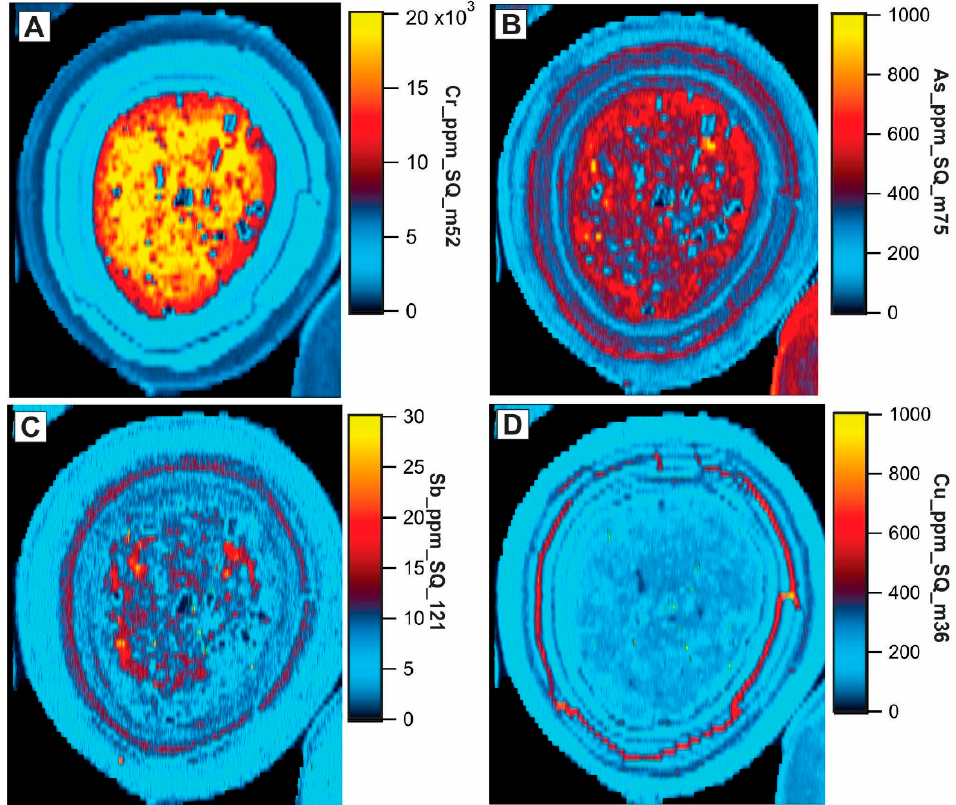
Figure 14. Laser ablation ICP-MS elemental maps showing Cr ( A ), As ( B ), Sb ( C ) and Cu ( D ) for a ferruginous pisolith (approximately 5 mm in diameter; PPS1) formed in the Perkolilli Shale (PPS).